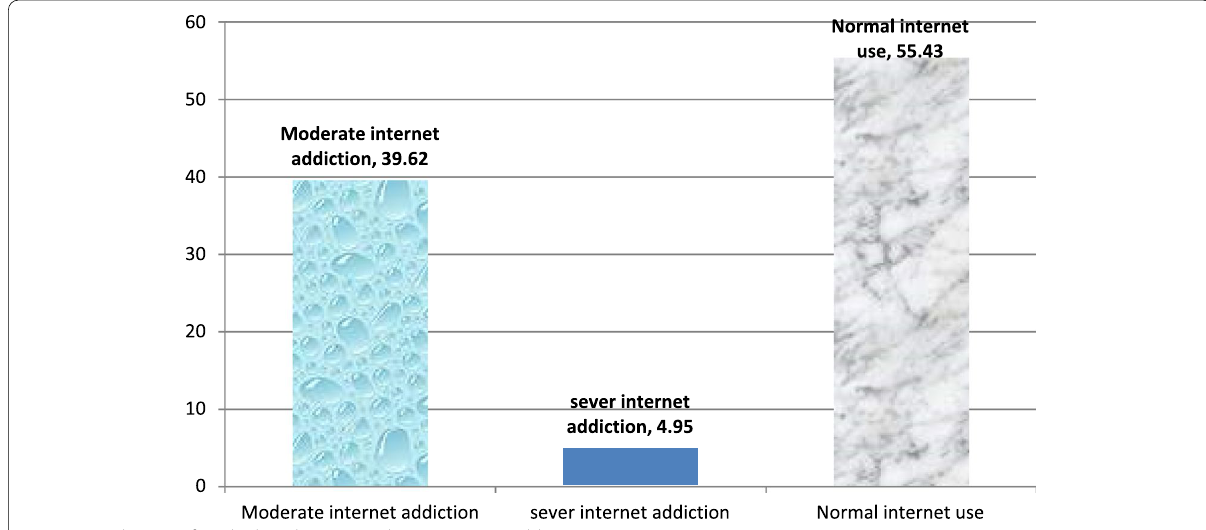
Fig. 1 Distribution of studied students according to Internet addiction